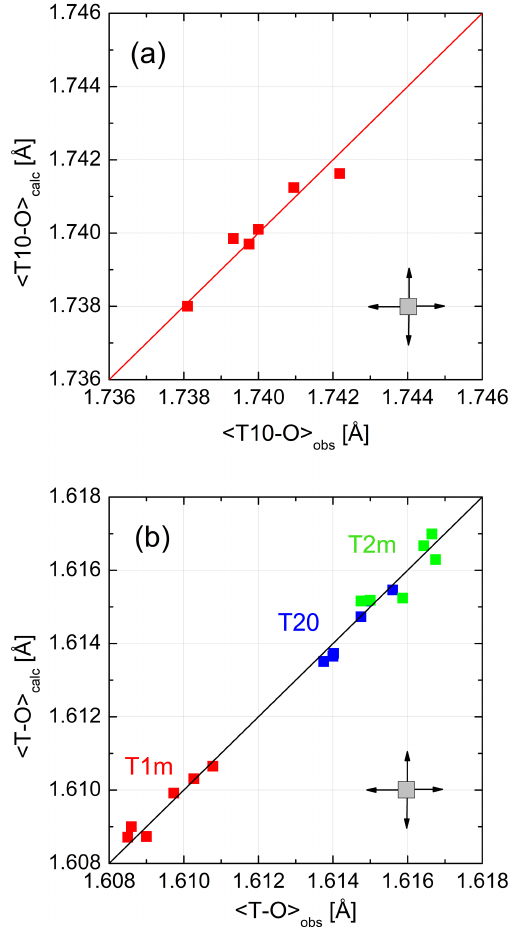
Figure 4. (a, b) Mean tetrahedral distances, (cid:104) T–O (cid:105) calc = (cid:104)(cid:104) T–O (cid:105)(cid:105)+ c 3 [ t − 0 . 25 ( 1 + n An ) ]+ c 4 (cid:49) (cid:104) f s ( O ) (cid:105) (Eq. 8), for six low-albite struc- tures plotted versus the observed distances. The variations follow straight lines with a slope of 1. No systematic deviations that would point to a model deficiency are apparent. The error cross indicates the approximate